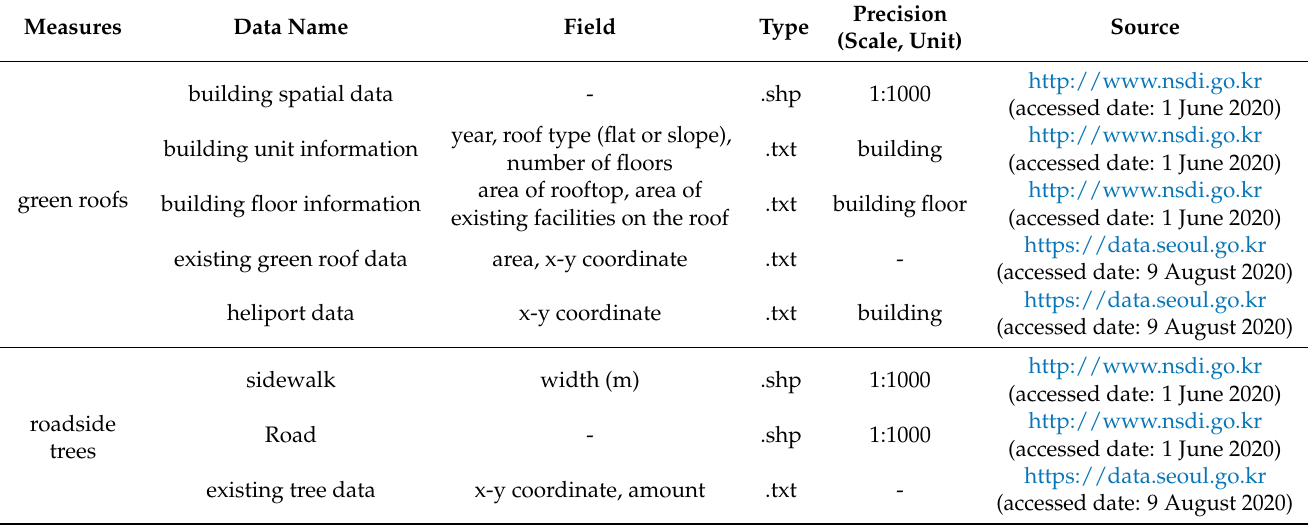
Table 1. Analytical data for the